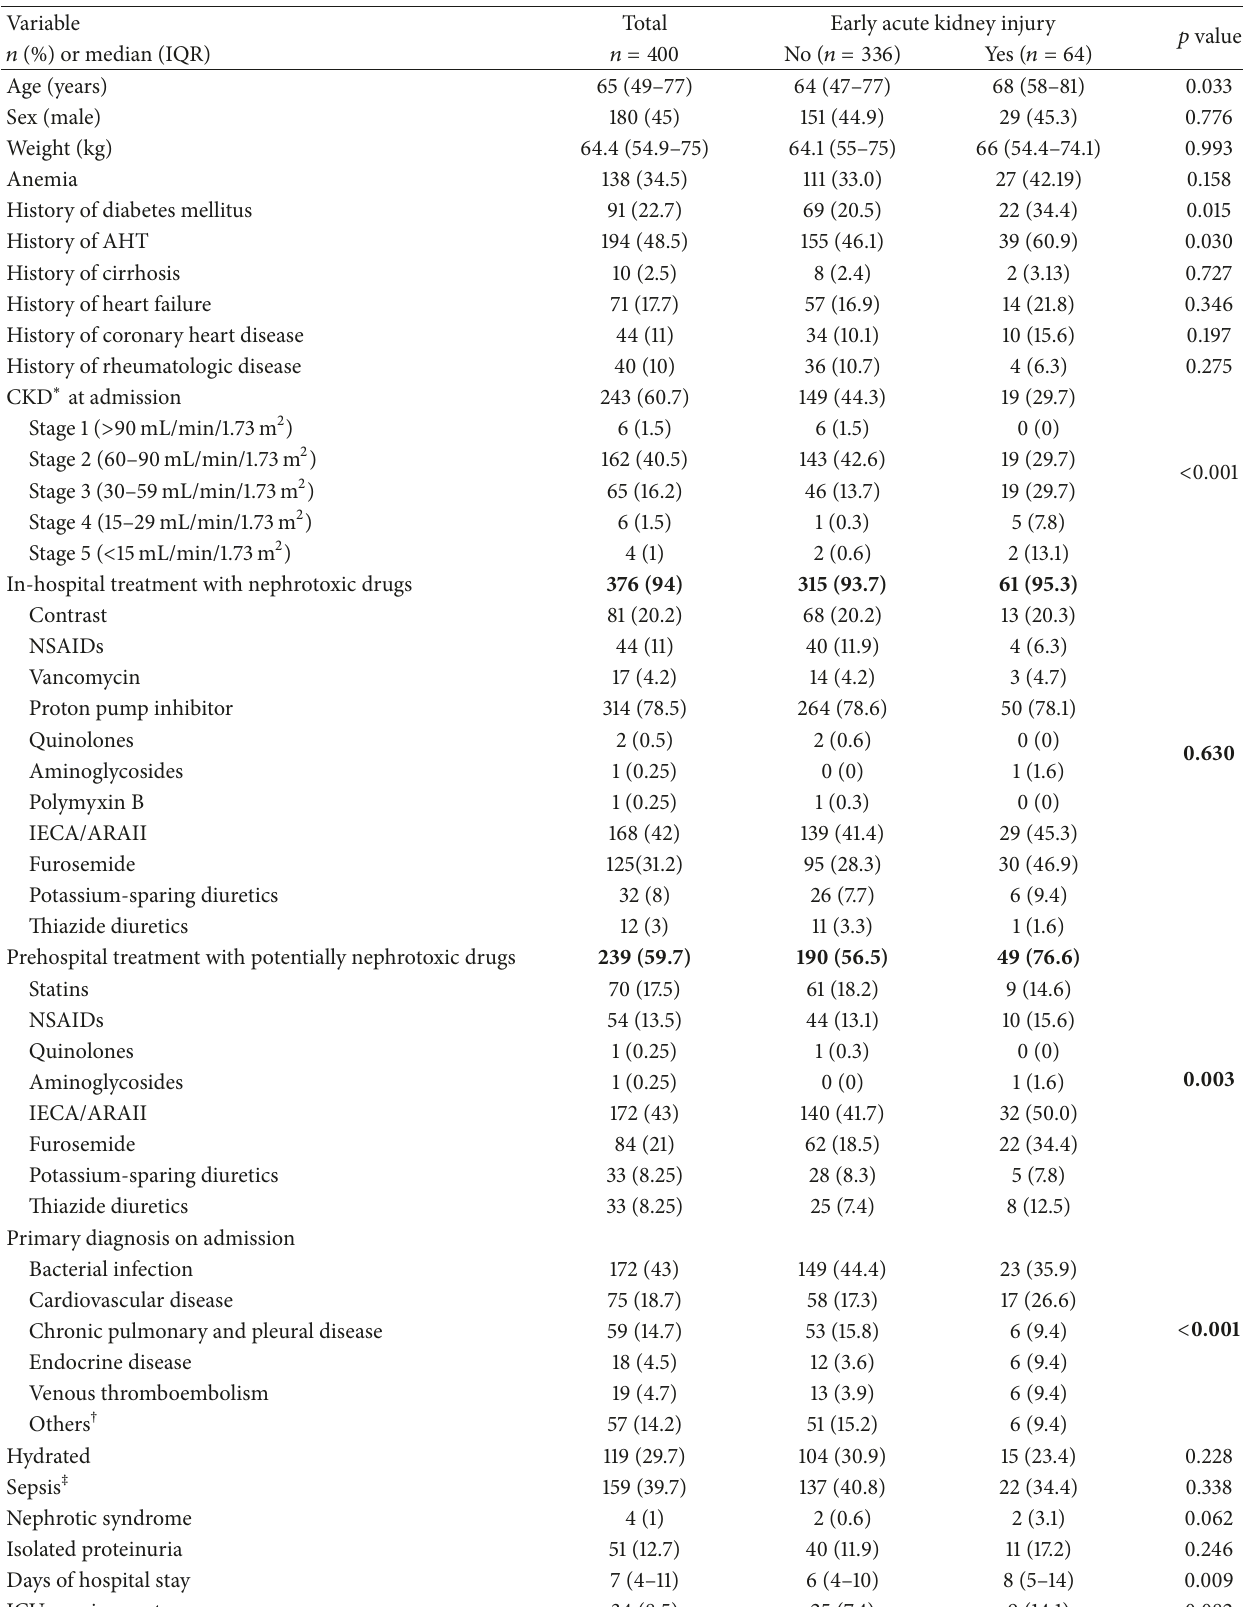
Table 1: Population